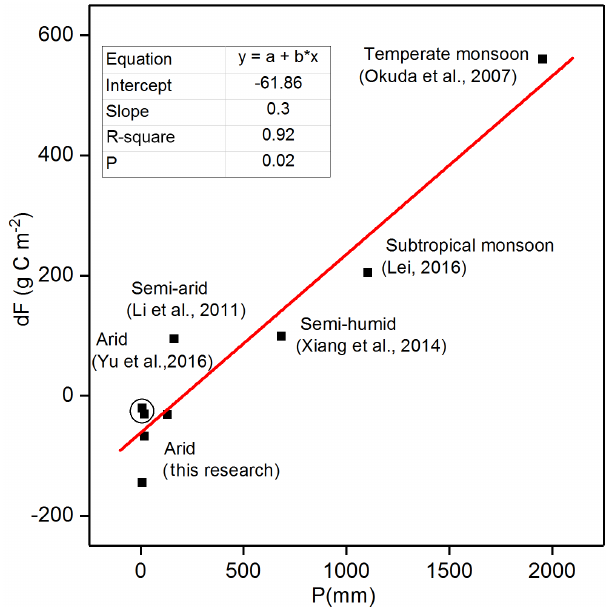
Figure 10. The relationship of the difference in soil respiration be- tween the mulched and non-mulched fields with precipitation; df represents the soil respiration in the non-mulched field minus that in the mulched field. Among the five points representing arid areas, the data from Yu et al. (2016) are within the circle, while those from our study are outside of the